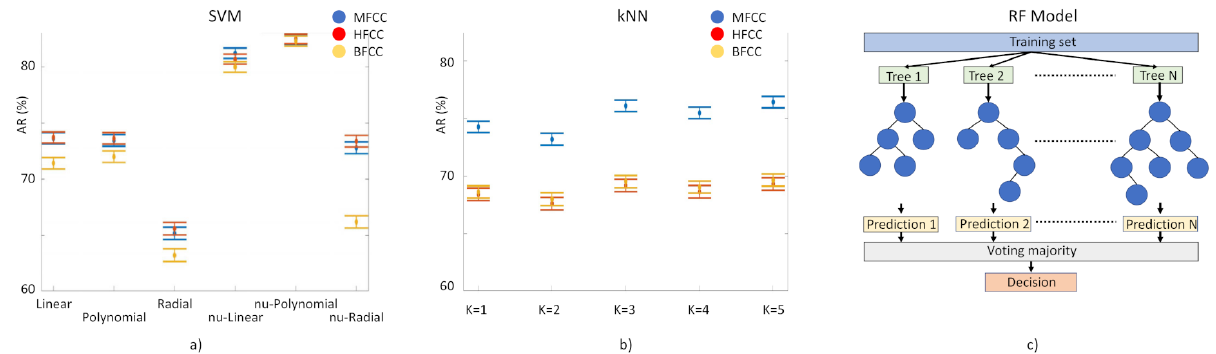
Figure 4. ( a ) SVM performance as a function of kernel selection. ( b ) kNN performance as a function of k, k = 1,5. AR with 90% confidence interval in both cases (Blue, MFCC. Yellow, BFCC. Red, HFCC). ( c ) Graphic representation of the RF model. Training data set is split into N different data subsets that feeds into the N generated decision trees (N = 100 in our study). Decision is taken following the final prediction, obtained by majority voting of the N decision trees, weighting the models according to their